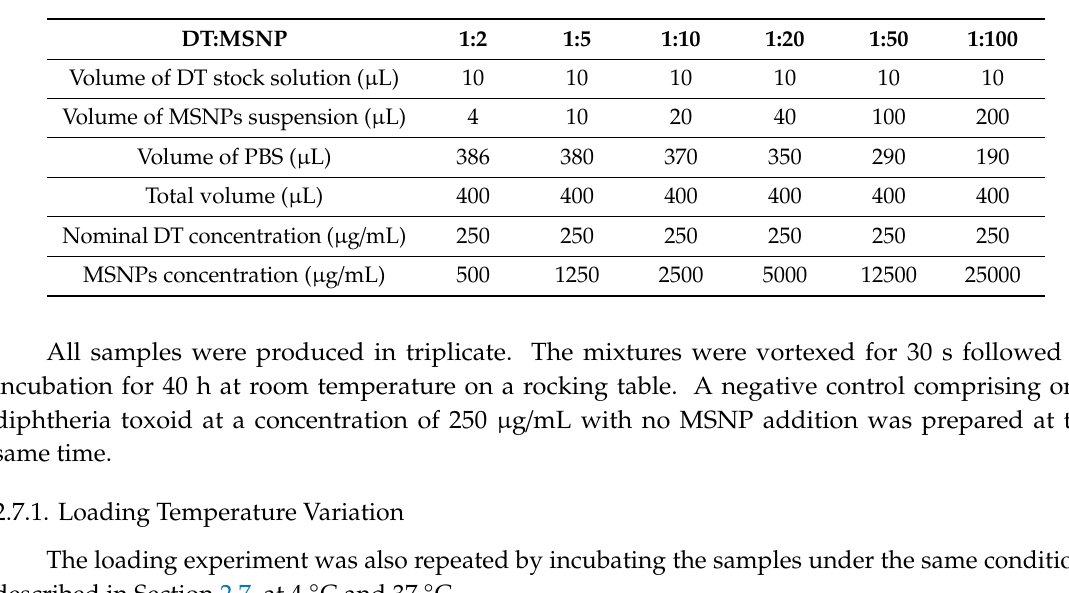
Table 1. Antigen loading onto mesoporous silica nanoparticles (MSNPs). The table shows the volume diphtheria toxin (DT) stock solution, MSNP-PBS suspension and PBS added in a single test tube in the DT loading experiments. The initial concentration of both nominal DT and MSNPs is